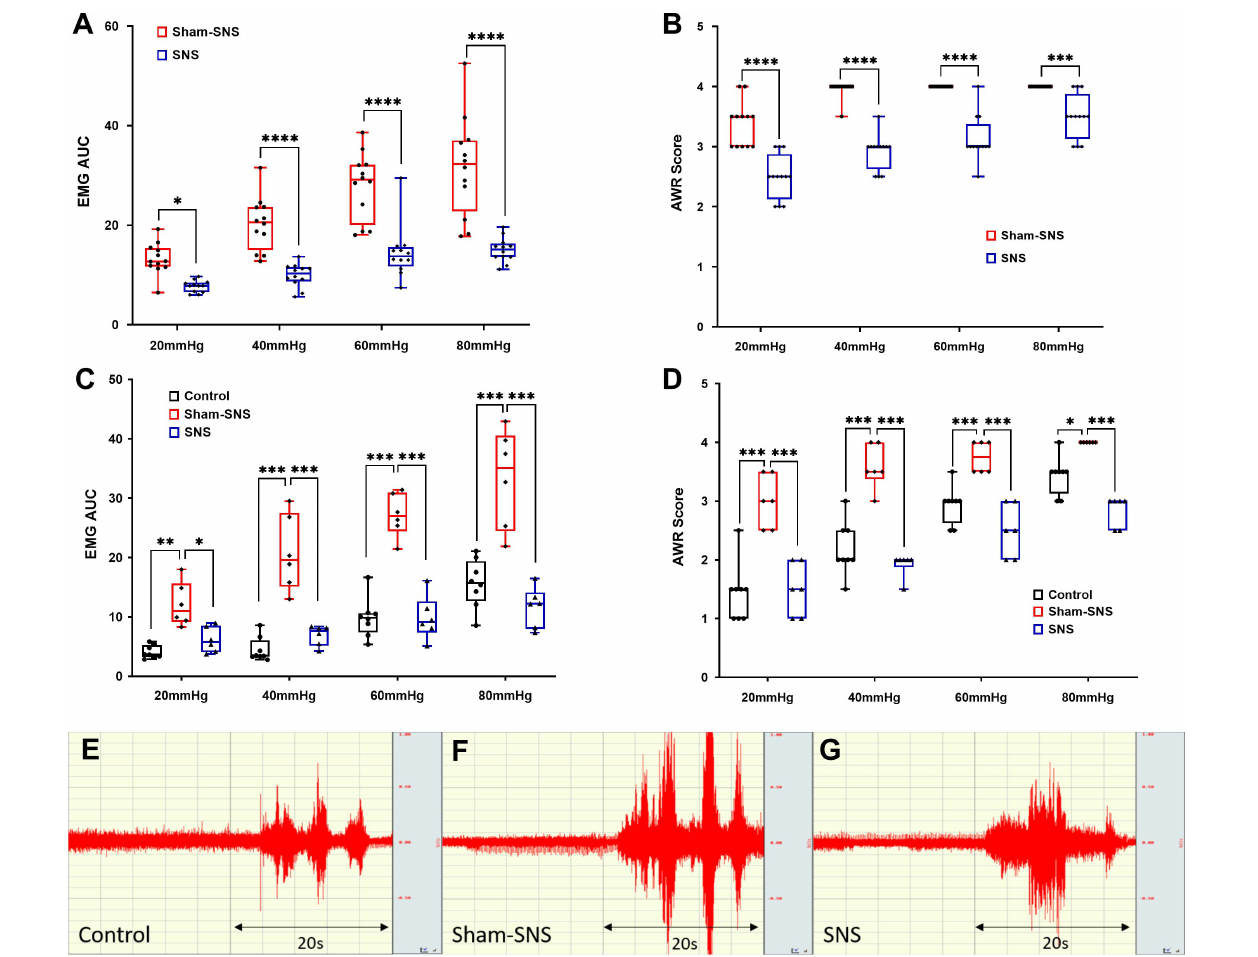
FIGURE 3 | The effects of acute and chronic SNS and sham-SNS on visceral hypersensitivity. EMG and AWR were assessed using colorectal distention test in hypersensitive and control (normal rats). (A,B) Effects of acute SNS (14 Hz, 330 µ s, 40% motor threshold, 30 min) on EMG and AWR of SNS and sham-SNS groups ( n = 12). In animal model of hypersensitivity, EMG and AWR were significantly lower in SNS-treated rats compared to sham-SNS (* p < 0.05, *** p < 0.001, **** p < 0.0001; EMG: Two-way ANOVA, Bonferroni). (C,D) Effects of chronic SNS (14 Hz, 330 µ s, 40% motor threshold, 3 weeks, 2 h/day, n = 6) on EMG and AWR of SNS and sham-SNS groups ( n = 6). Chronic SNS significantly reduced the EMG and AWR compared to sham-SNS and normalized the values comparable to the control ( n = 8) (* p < 0.02, ** p < 0.002, *** p < 0.003, **** p < 0.0001; Two-Way ANOVA, Tukey). (E–G) EMG tracing of CRD at 80 mmHg for 20 s in control, sham-SNS and SNS groups following chronic treatment. Values were represented as the means ± SE. AA, acetic acid; SNS, sacral nerve stimulation; HRV, heart rate variability; WB, western blot; IHC, immunohistochemistry; EMG, electromyogram; AUC, area under the curve; AWR, abdominal withdraw reflex; CRD, colorectal